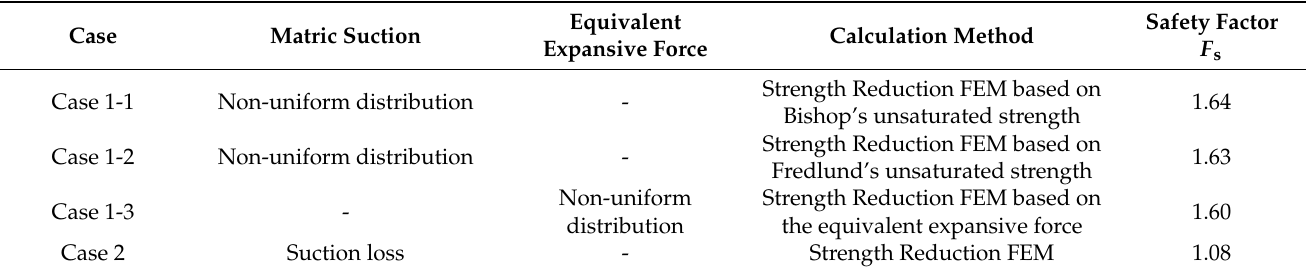
Table 3. Description of cases and safety factors.